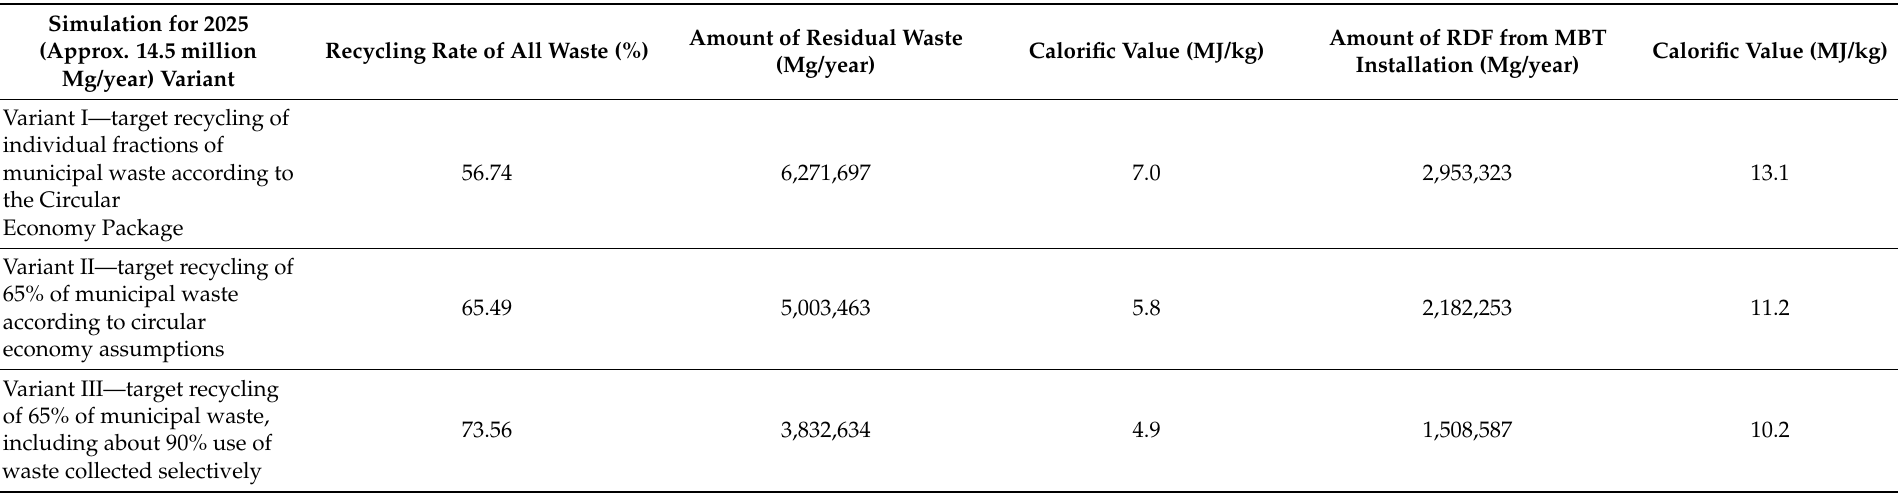
Table 10. The amount and calorific value of residual waste and RDF for various variants of the implementation of the Circular Economy